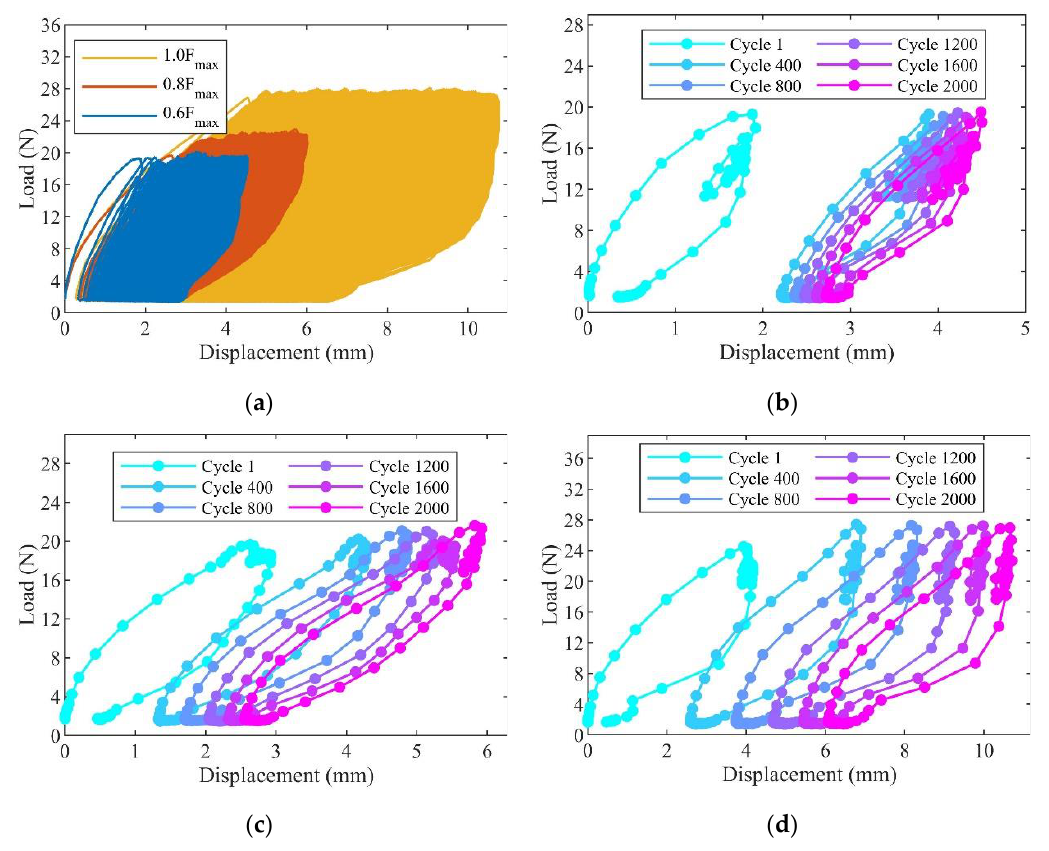
Figure 15. Variable loading amplitudes displacement–load hysteresis curve ( θ = 45 ◦ ): ( a ) total, ( b ) Q C = 0.6 F max , ( c ) Q C = 0.8 F max , ( d ) Q C = 1.0 F max .